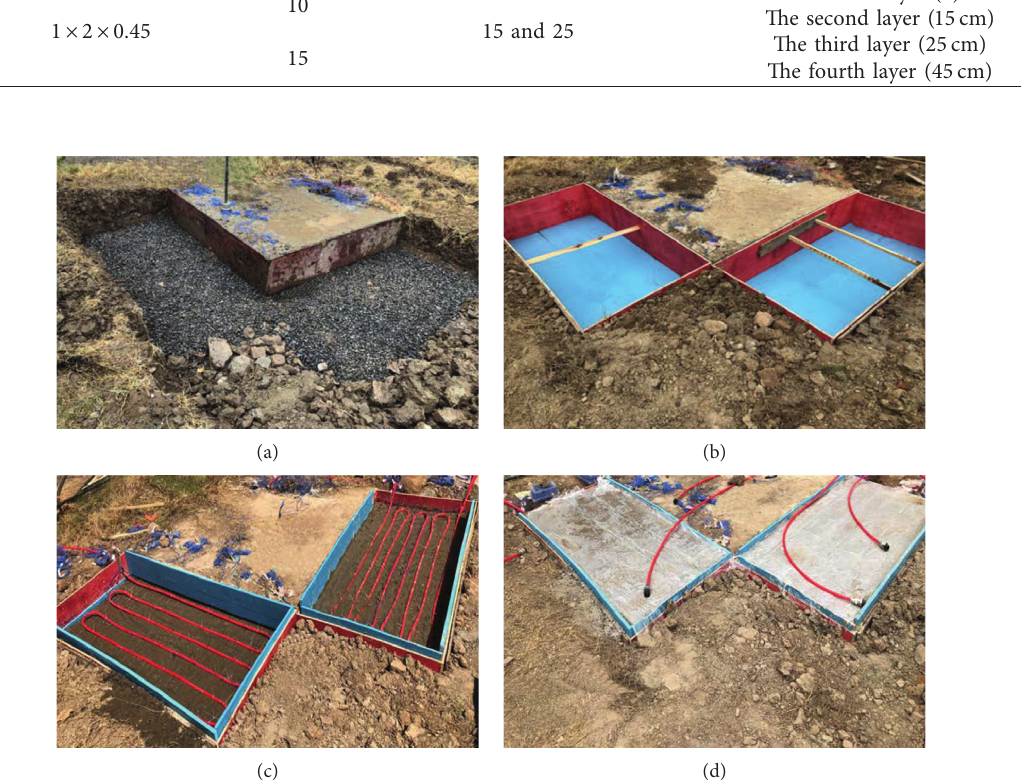
Figure 3: Construction flow chart. (a) Macadam laying. (b) Support mould. (c) Geothermal pipe laying. (d) Concrete curing.